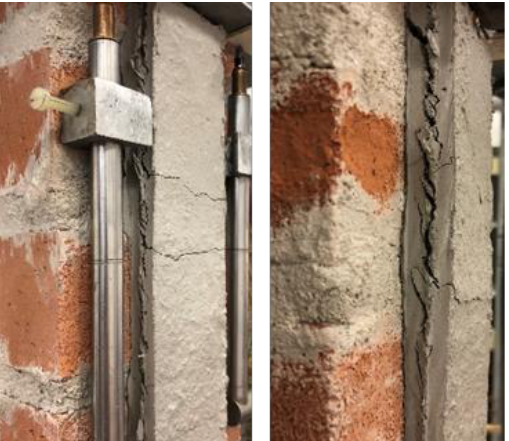
Figure 8. Opening of matrix transversal cracks and longitudinal cracks at the matrix internal–external layer interface in specimen DS_300_50_P_3 [28].